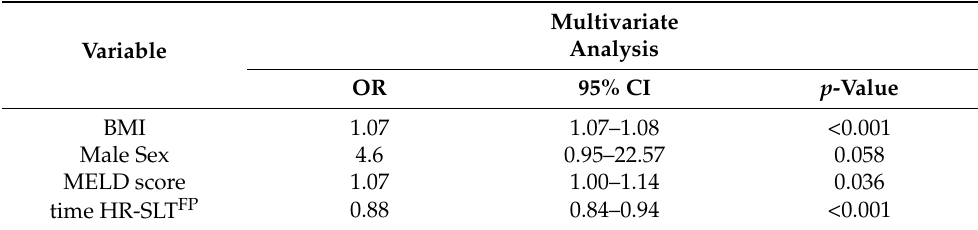
Table 5. Multivariate analysis of predictors of severe complications after SLT using fractional polynomial (FP) function of time